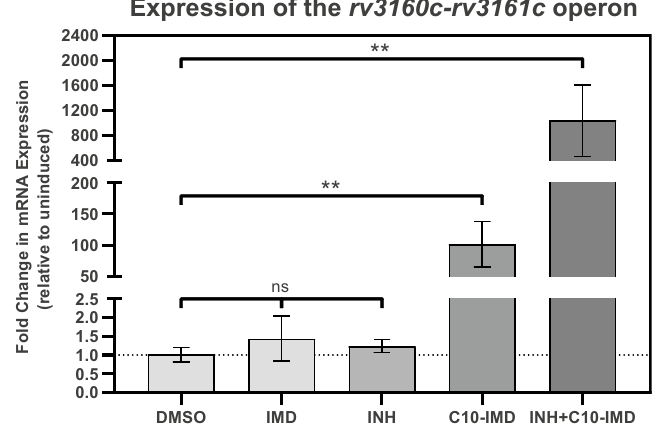
Figure 1. Expression of the rv3160c-rv3161c operon is significantly induced by C10-IMD. Mtb Erdman WT was cultivated in Sauton’s medium at 37 °C until its OD 600 reached 0.3. The cells were then exposed to 0.1% DMSO, 0.1 µg/ml INH and 25 µM C10-IMD separately or in combination for 48 h at 37 °C. Differences in expression of the rv3160c-rv3161c operon were determined by qRT-PCR analysis performed by targeting rv3161c coding region. Expression of the sigA gene was determined by qRT-PCR analysis and used as housekeeping control. Relative fold-change in rv3160c-rv3161c operon expression was calculated for each biological replicate by the Livak (2 −ΔΔCt ) method. Bar graphs were plotted based on average and standard deviation obtained from three independent biological replicates and statistical analysis comparing to the DMSO control was determined by one-tail t -test that was performed using GraphPad Prism version 8.4.3 for Windows, GraphPad Software, San Diego, California USA, www.graph pad.com (** p <